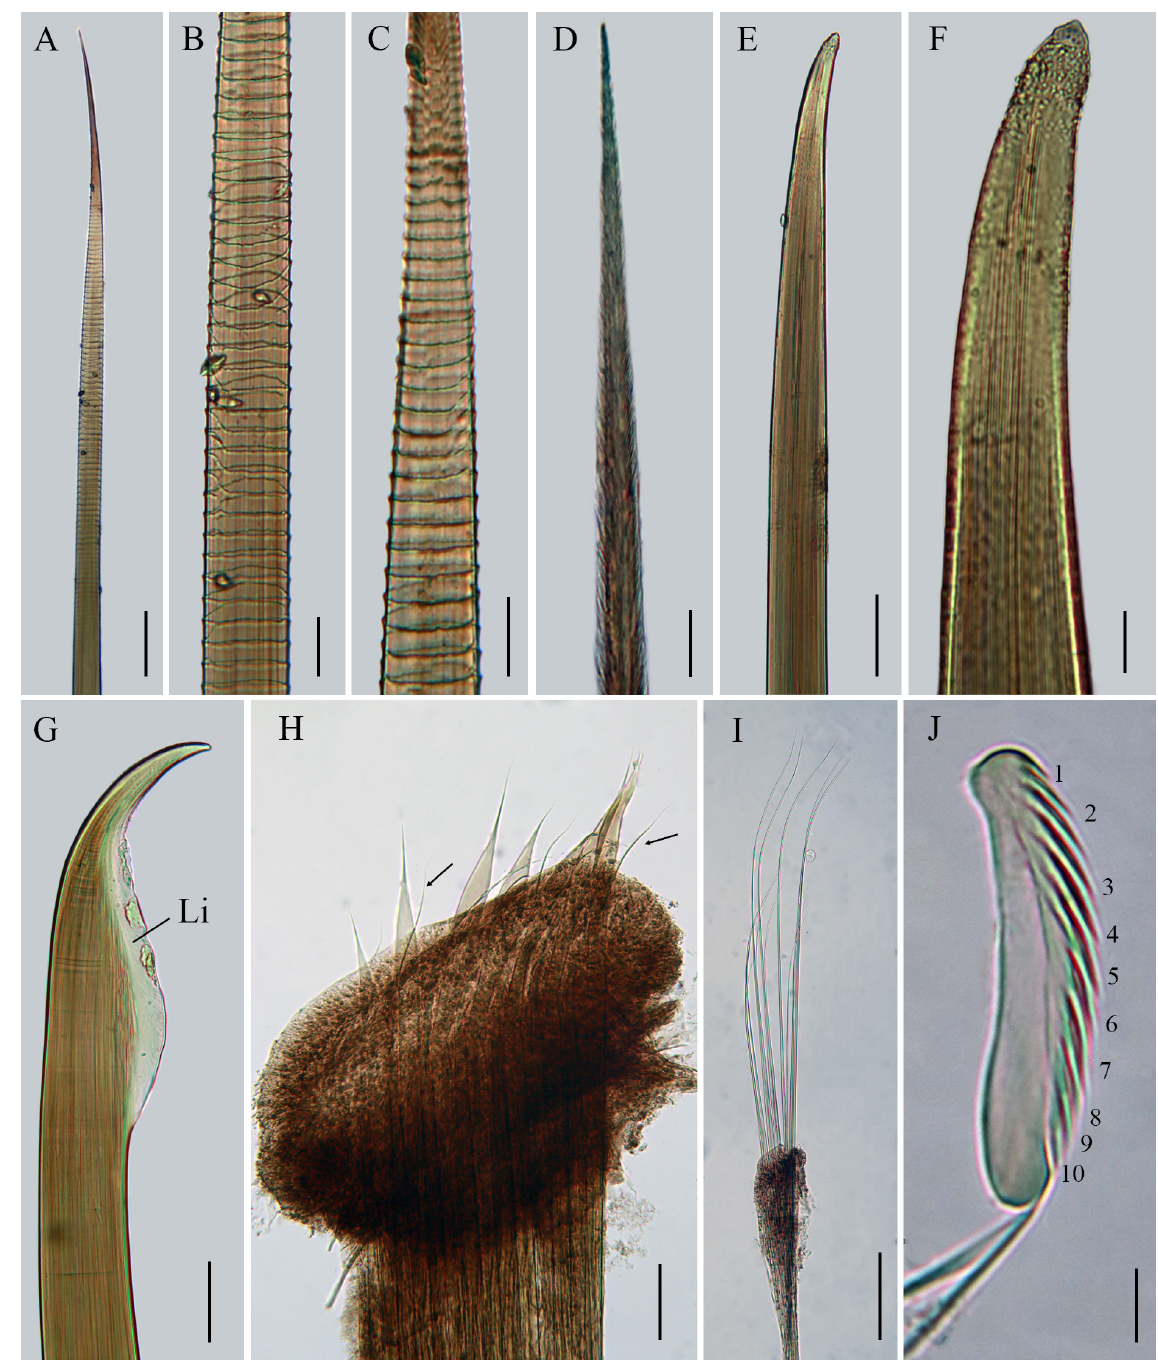
Fig. 17. Phalacrostemma sp. (UMML-22.1194). A . Complete outer palea. B . Distal region of outer palea. C . Middle region of outer palea. D . Tip of outer palea. E . Inner palea. F . Tip of inner palea. G . Nuchal hook. H . Parathoracic notochaetae. I . Abdominal chaetae. J . Uncini. Abbreviation: Li = limbation. The arrows indicate capillary chaetae. Numbers indicate the rows of teeth. Scale bars: A, I = 200 µm; B = 50 µm; C, E = 100 µm; D, F–H = 20 µm; J = 10